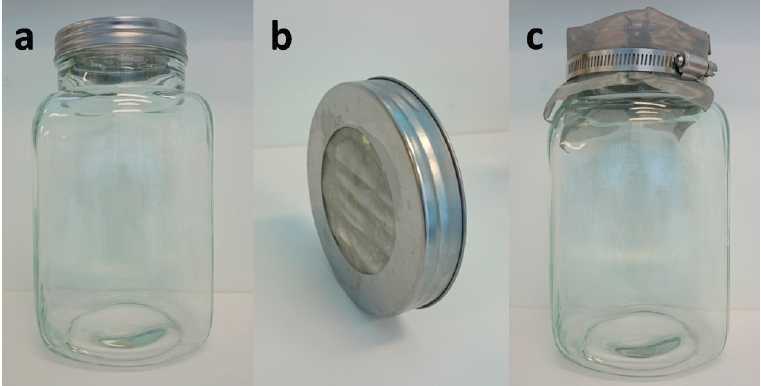
Figure 1. Storage containers for rearing and maintaining the larvae. Glass housing jar approximately 22 cm height with wide neck for housing larval colonies ( a ). Modified jar lid ( b ). Ultra-thin stainless-steel wire mesh is fixed by a hose clamp around the lid as a secondary layer ( c